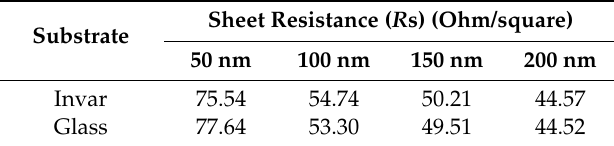
Table 1. Sheet resistance of ITO films on the SiO 2 /invar and glass substrates with increasing ITO thickness.